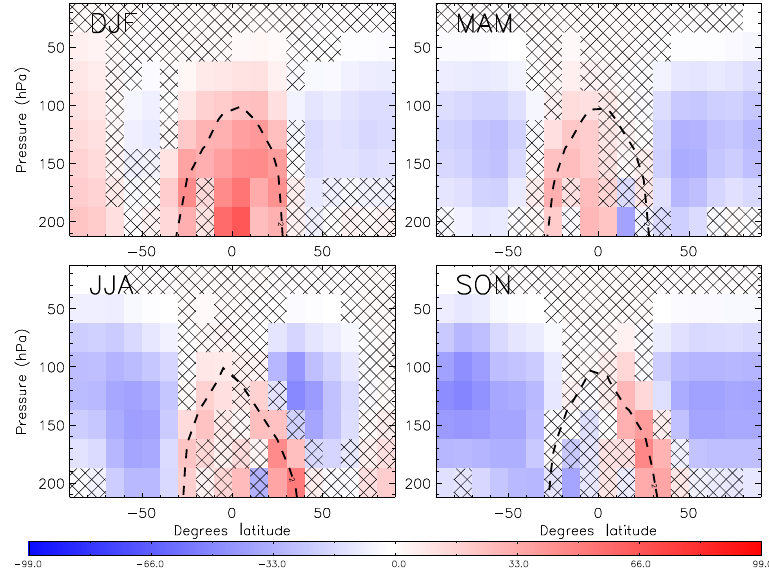
Figure 17. As Fig. 16 but for UoL MIPAS observations and application of the UoL averaging kernels to the TOMCAT model